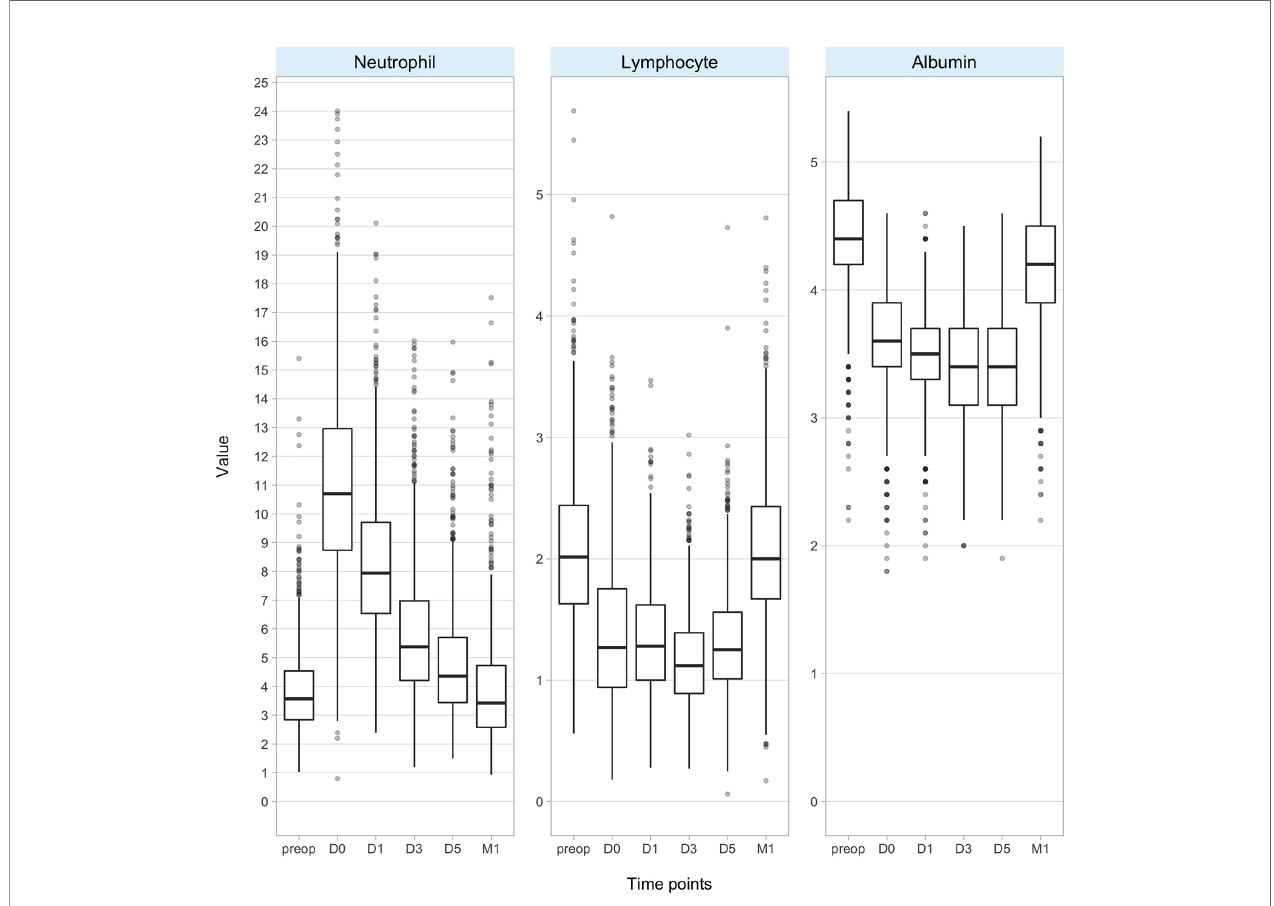
FIGURE 1 | Box plots of neutrophil count, lymphocyte count, and albumin level at different time points. Y-axis represents × 10 3 cells/ml for neutrophils and lymphocytes and g/dl for albumin. (D, day; M, month; preop, preoperative).